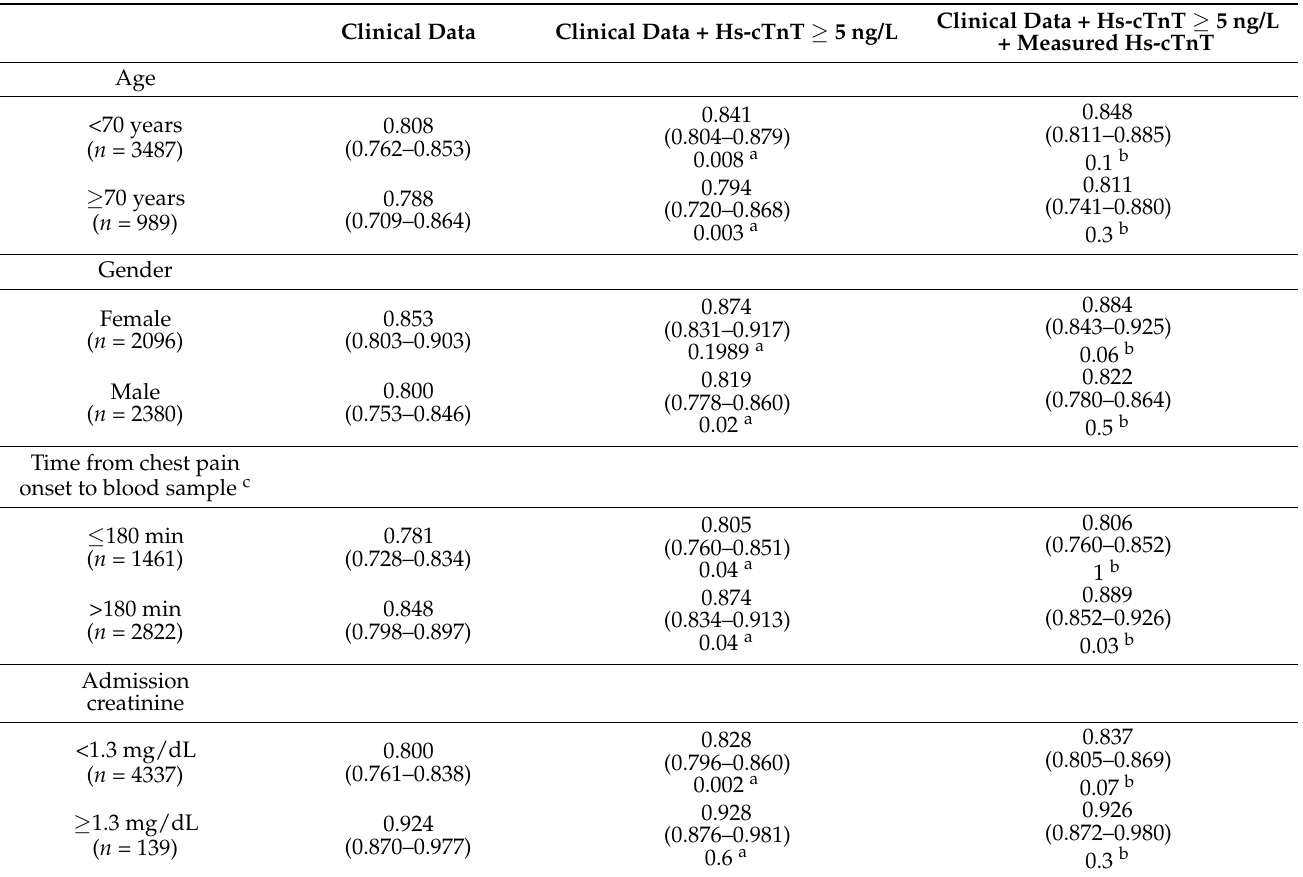
Table 5. Discrimination accuracy (C-statistic) of the predictive models for the primary (death or acute myocardial infarction) endpoint in different